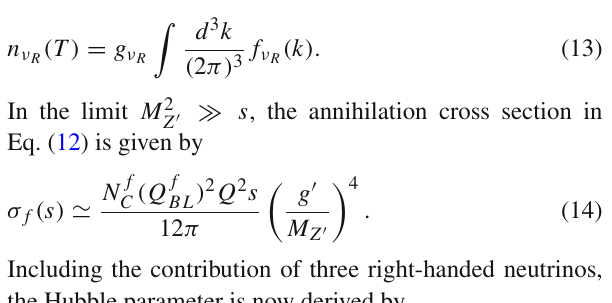
tion (shown in Fig. 2b), mainly due to the suppression of BR ( Z (cid:2) → (cid:11) + (cid:11) − )